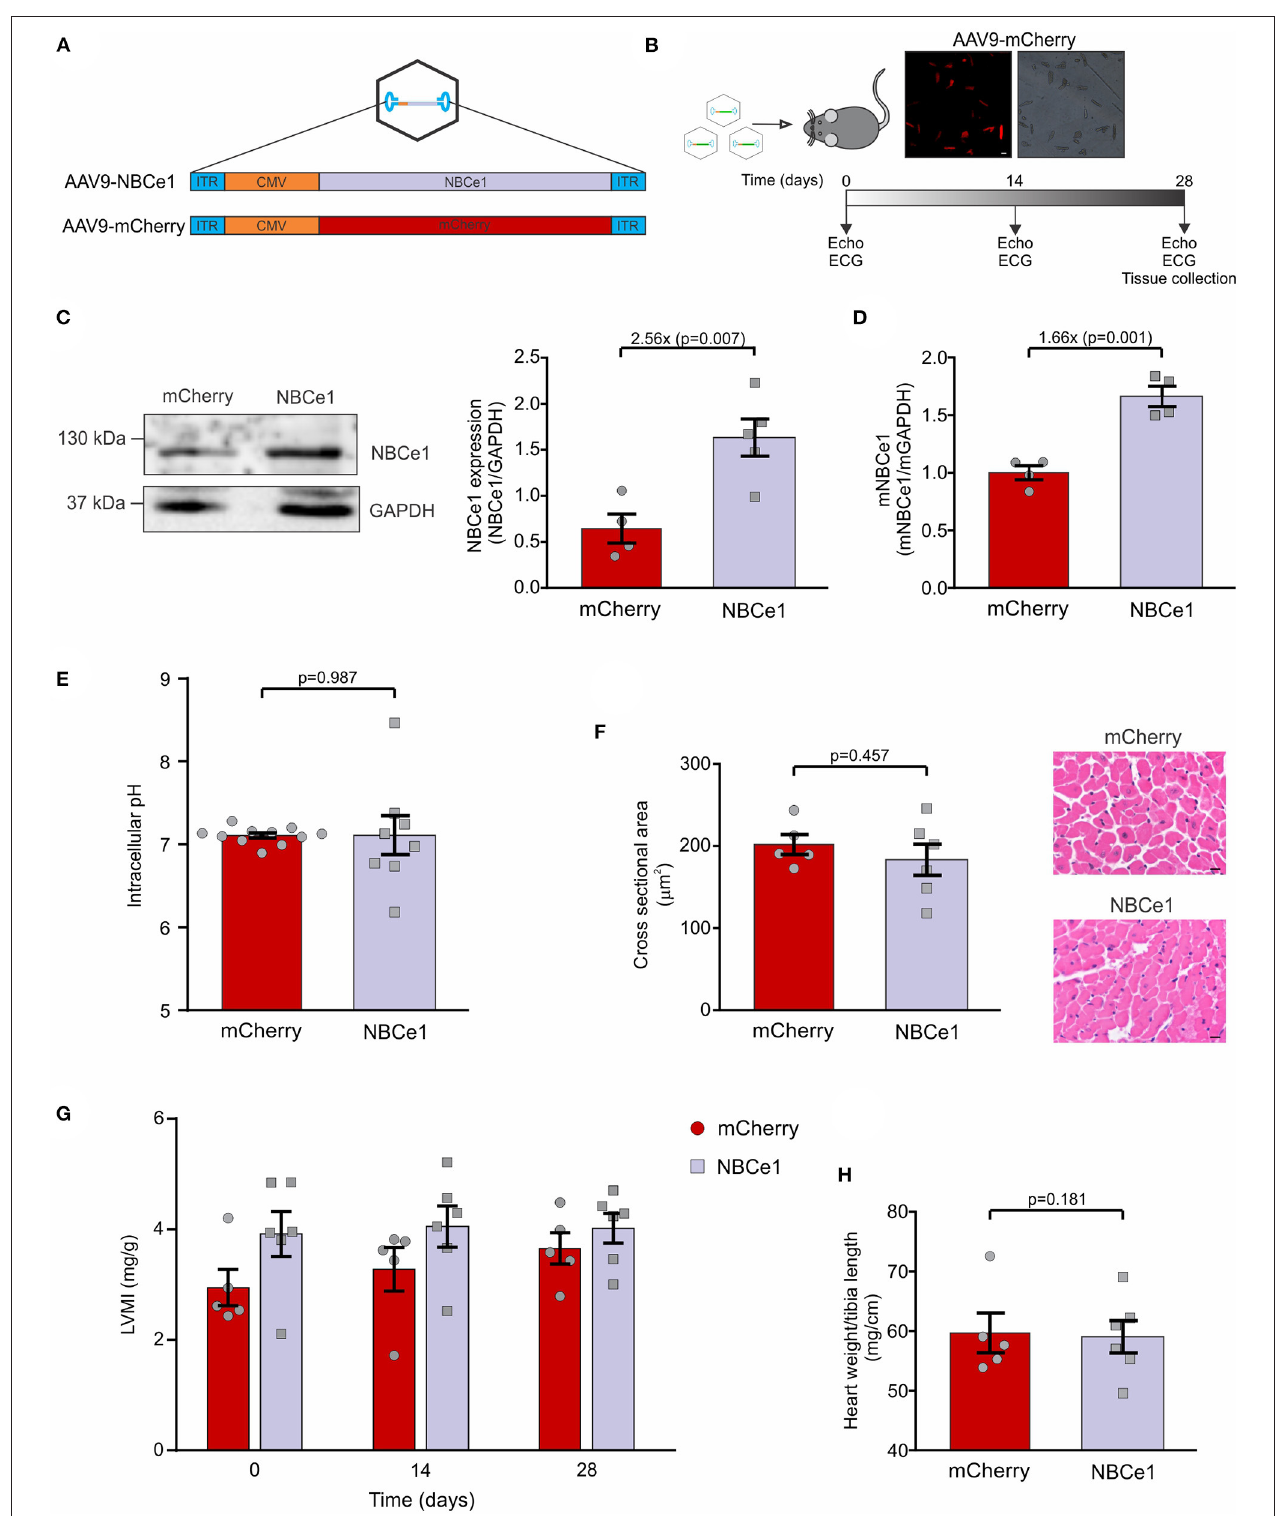
FIGURE 1 | In vivo overexpression of NBCe1 in mice. (A) Diagram of packaging vector containing AAV2-ITRs and the cytomegalovirus (CMV)-driven NBCe1 or mCherry transgene. These transgenes were packaged within cardiotropic adeno-associated virus 9 (AAV9). (B) Scheme of the experimental design. Echocardiography and ECG recordings were obtained before and after 14 and 28 days of AAV9 tail injection. On day 28 mice were sacrificed. (Top) Fluorescent microscope images of isolated cardiomyocytes showing mCherry transduction. White scale bar corresponds to: 25 µ m. (C) NBCe1 protein expression